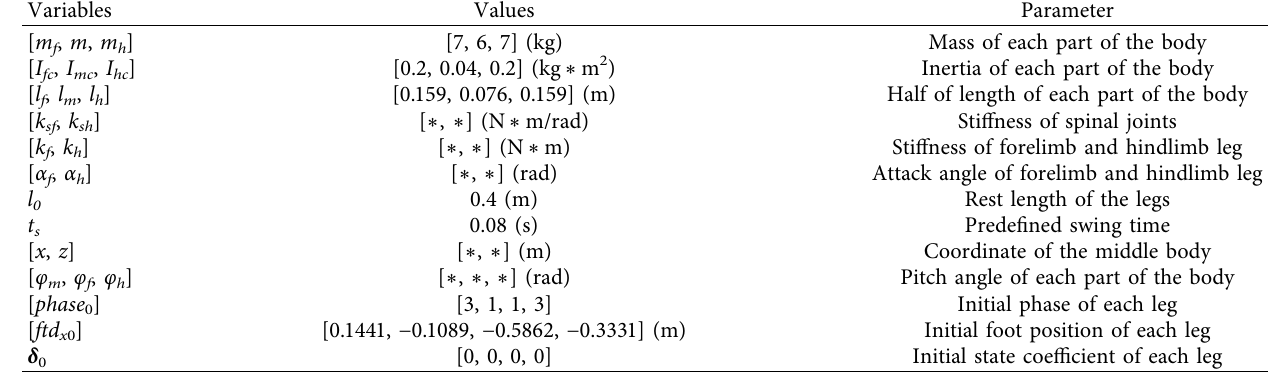
Table 1: Related variables of the model with two spinal joints.